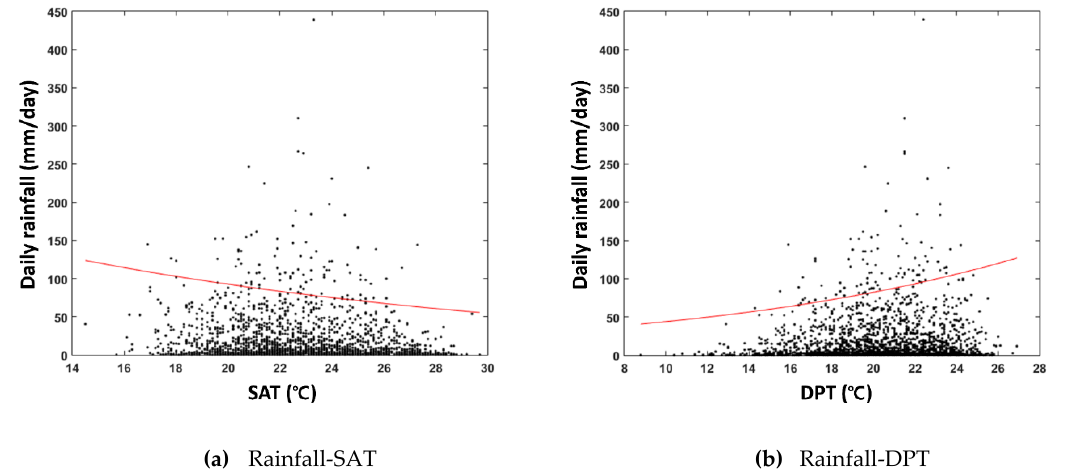
Figure 1. Sensitivity of 95% daily rainfall depth at Busan site.